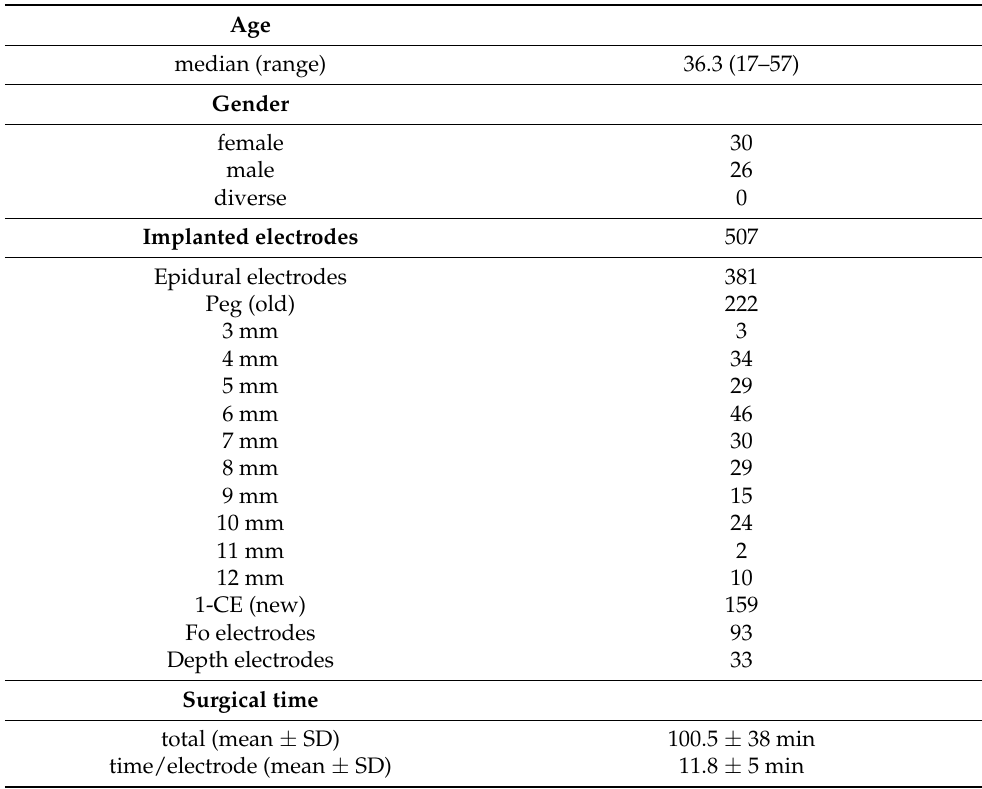
Abbreviations: Fo = foramen ovale; SD = standard deviation.